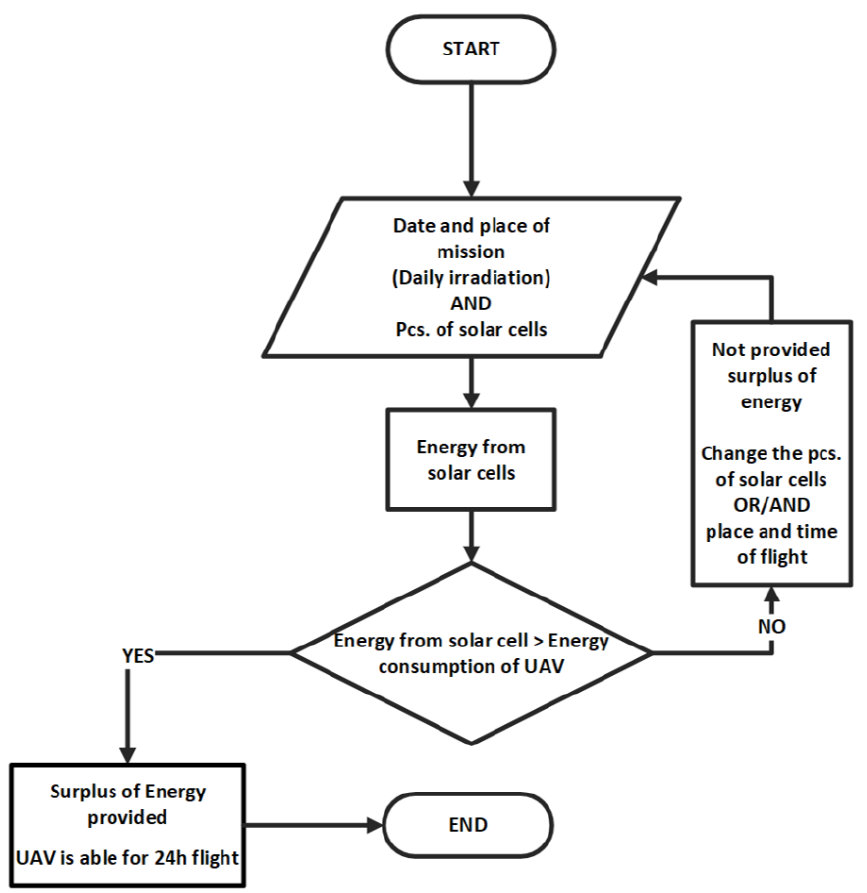
Figure 10. Flow chart of the energy balance of the UAV.